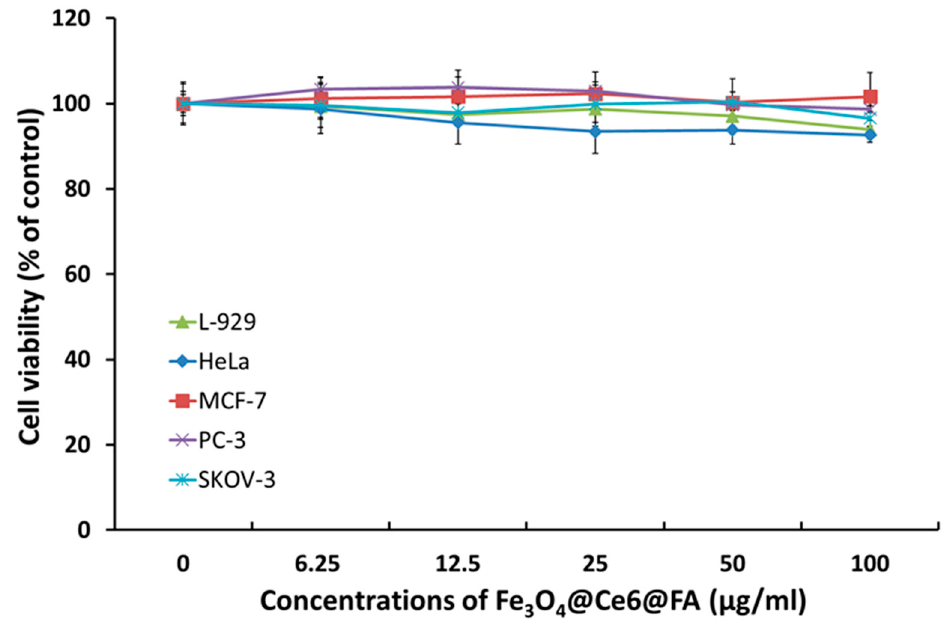
Figure 4. In vitro cytotoxicity of FCF NPs in various cell lines. Cytotoxicity of FCF NPs in L-929 (normal fibroblast), HeLa (cervical adenocarcinoma), MCF-7 (breast adenocarcinoma), PC-3 (prostate adenocarcinoma), and SKOV-3 (ovary adenocarcinoma) cells. All cells were transfected with GFP. The viability of each cell type was detected using a CCK-8 kit following incubation with FCF NPs for 24 h under dark conditions. Data for cytotoxicity are expressed as a mean ± S.D. (n =